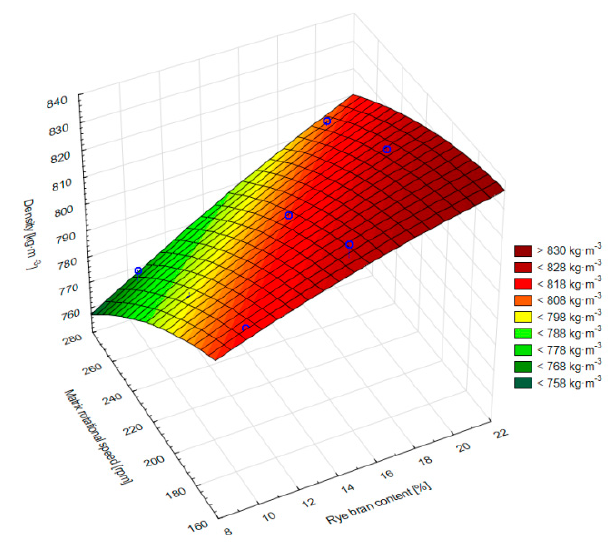
Figure 7. The impact of rye bran and rotational speed of the matrix on the density of cherry stone stone granules.